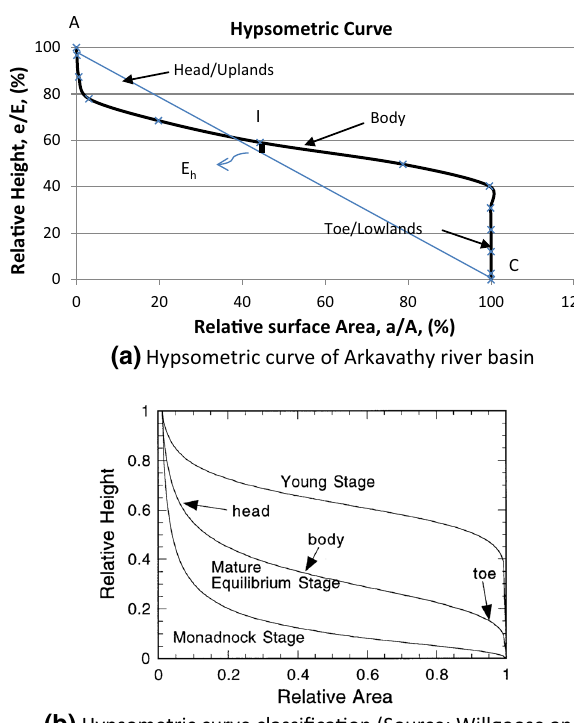
Fig. 6 Classification of Arkavathy river basin as contour line classes at 100-m interval in ArcGIS 10.2 for derivation of hypsometric curve in Arkavathy river